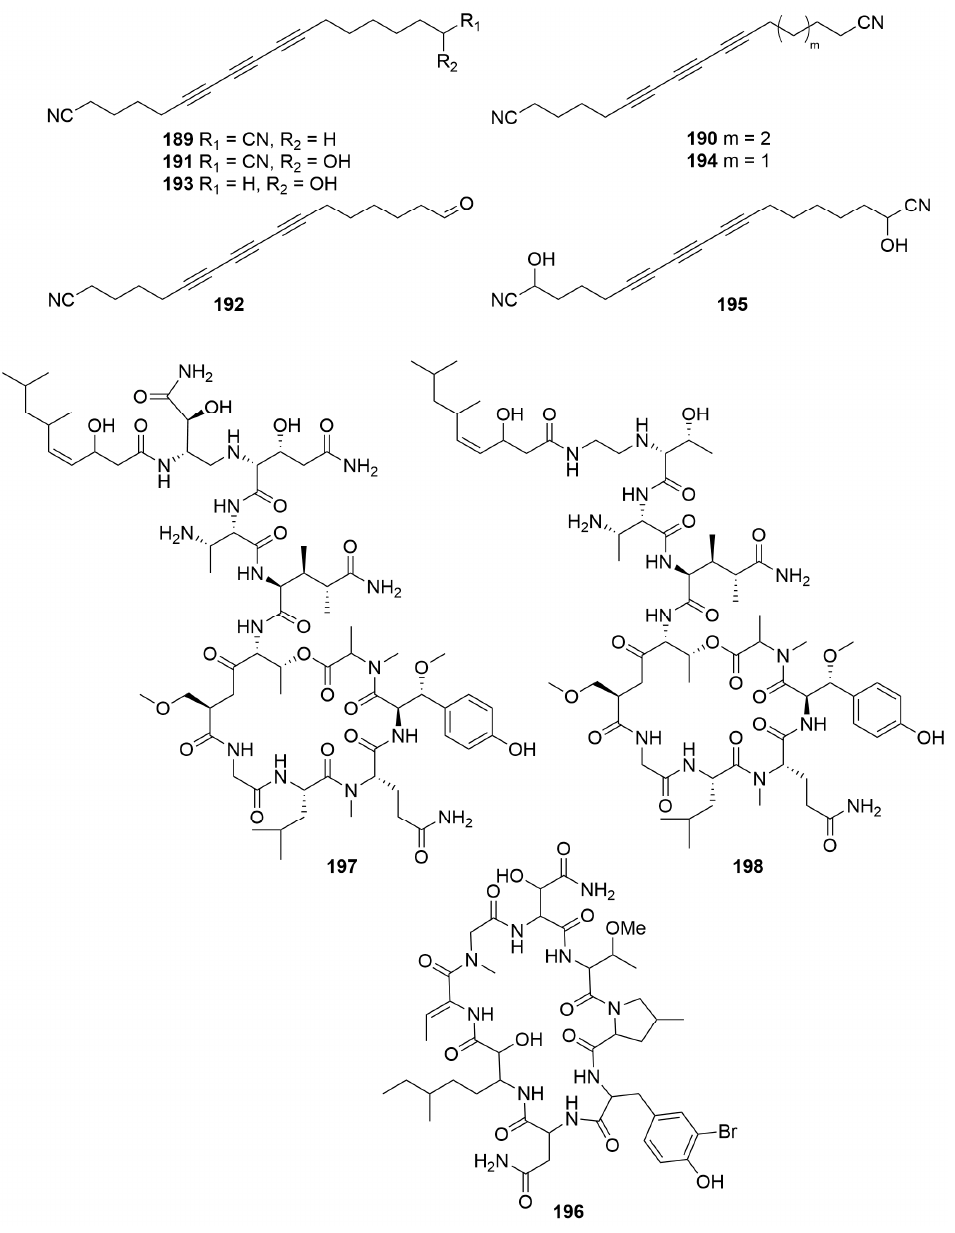
Figure 13. Compounds 189 to 196